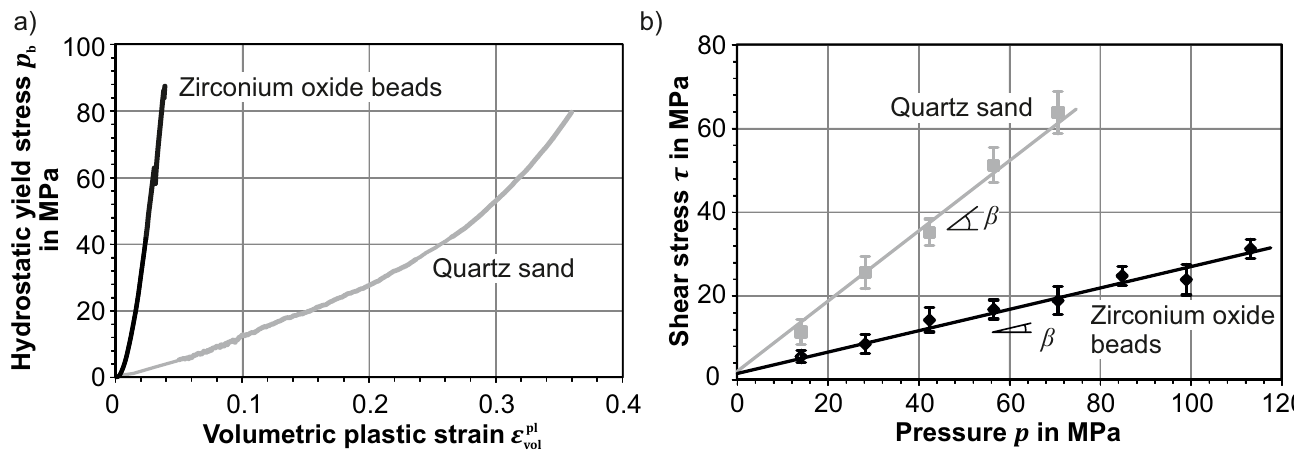
Figure 12. Yield stresses of quartz sand and zirconium oxide beads for ( a ) volumetric compression and ( b ) under shear loading, according to